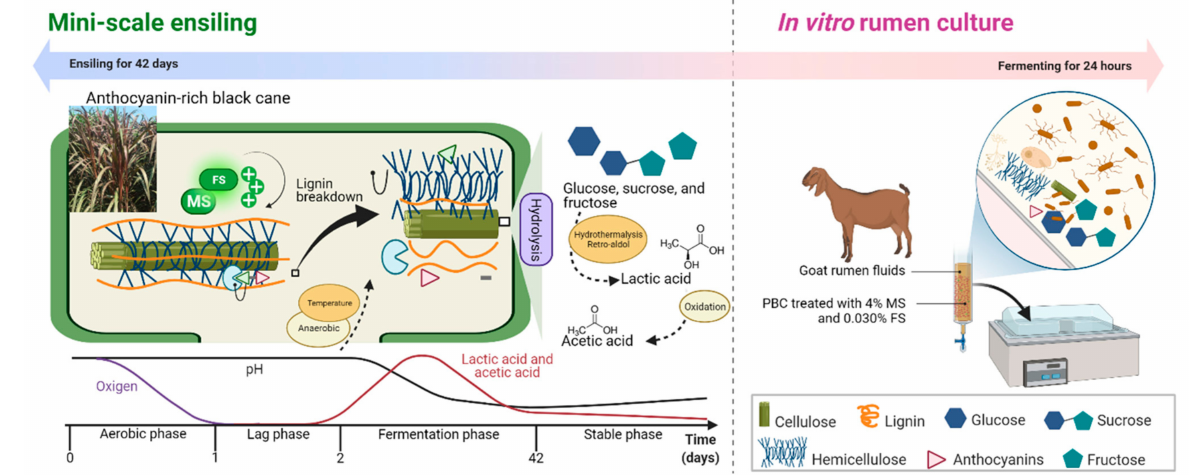
Figure 1. Silages of anthocyanin-rich black cane prepared with molasses (MS) and/or ferrous sulphate (FS) combinations improve silage quality and ruminant